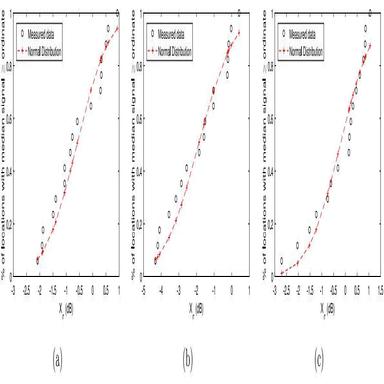
Scatter plot of shadowing showing Gaussian CDF in (a) 300–319 GHz, (b) 340–359 GHz and (c) 380–399 GHz.